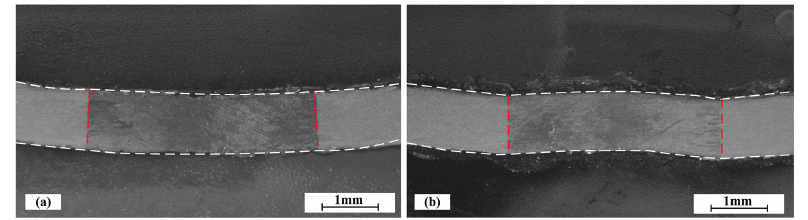
Figure 13: Weld stereomicroscope images under different defocusing distance of (a) sheet No. 1 and (b) sheet No. 5.